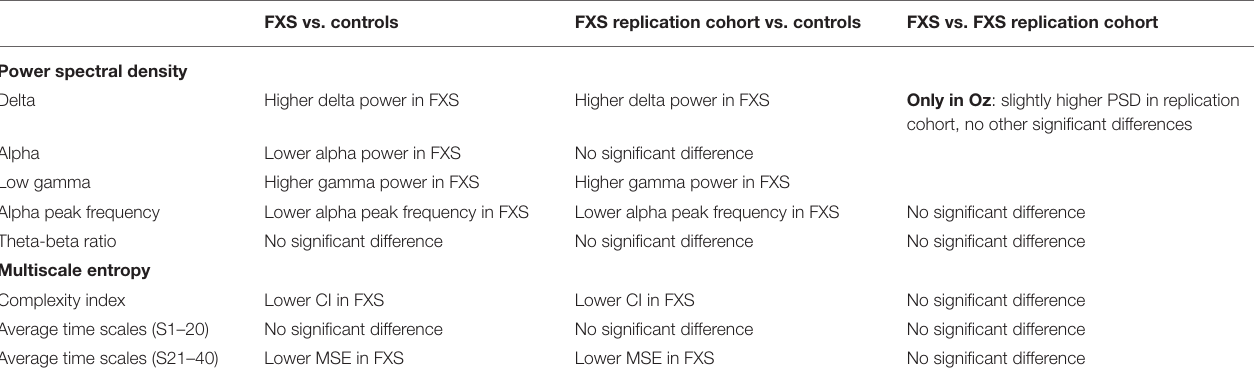
TABLE 4 | Main results of the FXS cohorts.